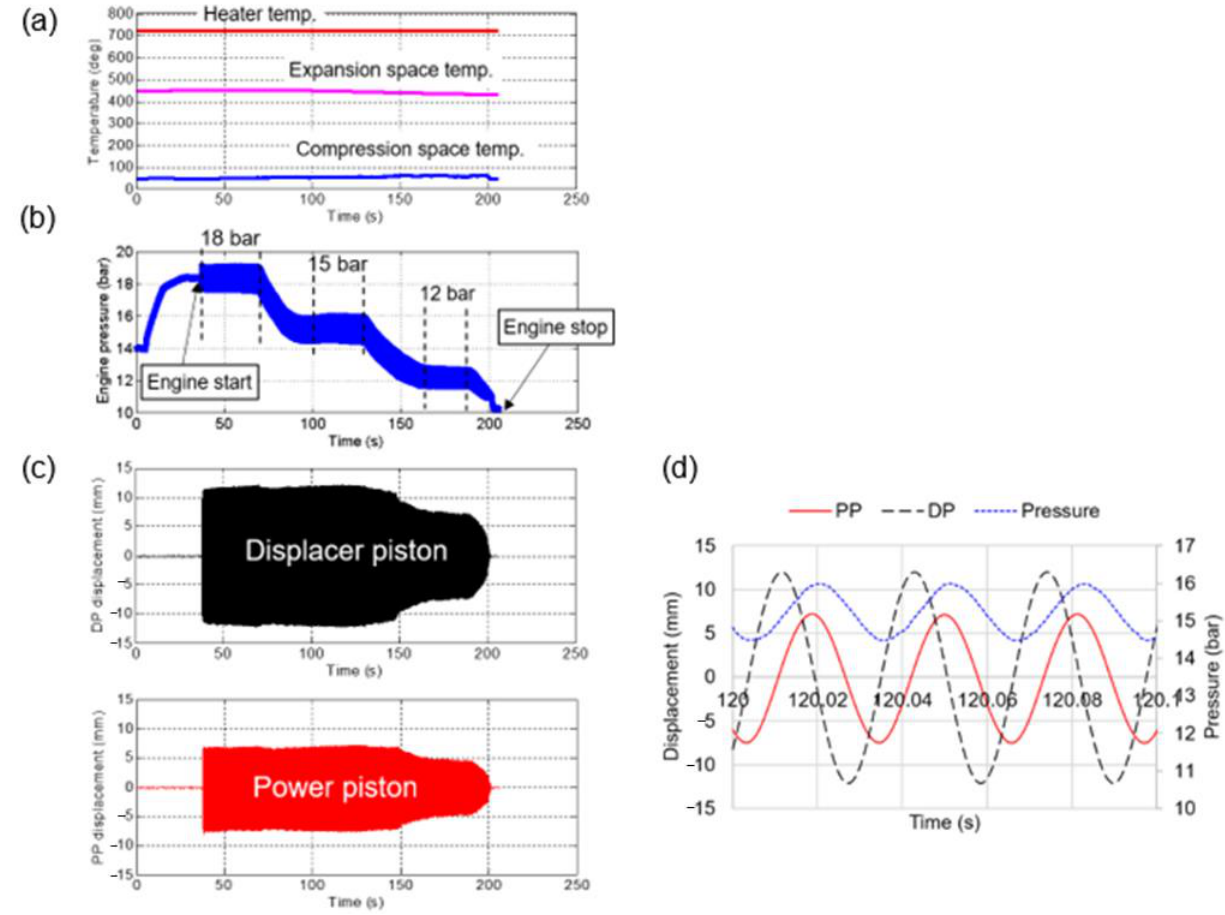
Figure 8. Measured ( a ) temperatures, ( b ) working pressure, and ( c , d ) DP and PP displacements for decreasing control pressures of 18, 15, and 12 bar under a load resistance of 80 Ω for case 3.